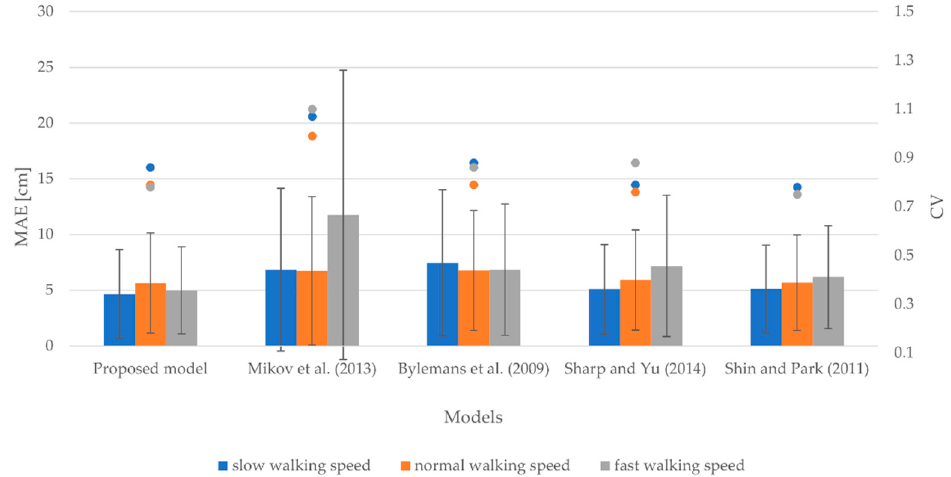
Figure 6. MAEs, SDs, and CVs for slow, normal, and fast walking speeds considering the smartphone attached to the thigh.